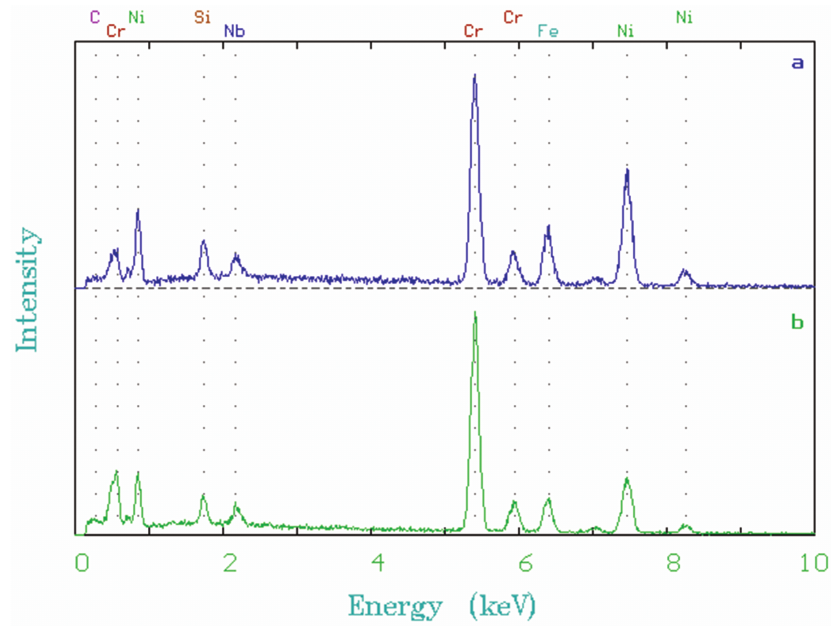
Figure 7: EDX spectra of the secondary precipitates in samples aged for 500 (a) and 1000 h (b).